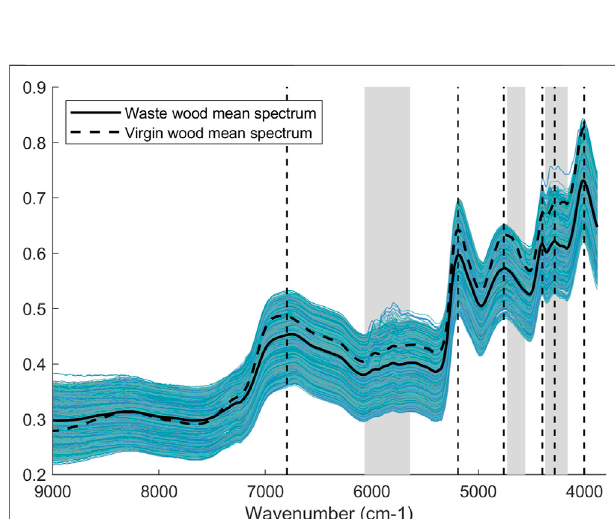
FIGURE 2 | All the spectra of waste wood samples with the mean spectrumofallthewastewoodsampleshighlightedwithasolidblackline,and the mean spectrum of virgin wood samples highlighted with a dotted black line.Verticaldottedlinesrefertothemostrelevantwavenumbersandare also reported in Table 3 . The grey areas highlight the spectral areas mostly associated with glue compounds.